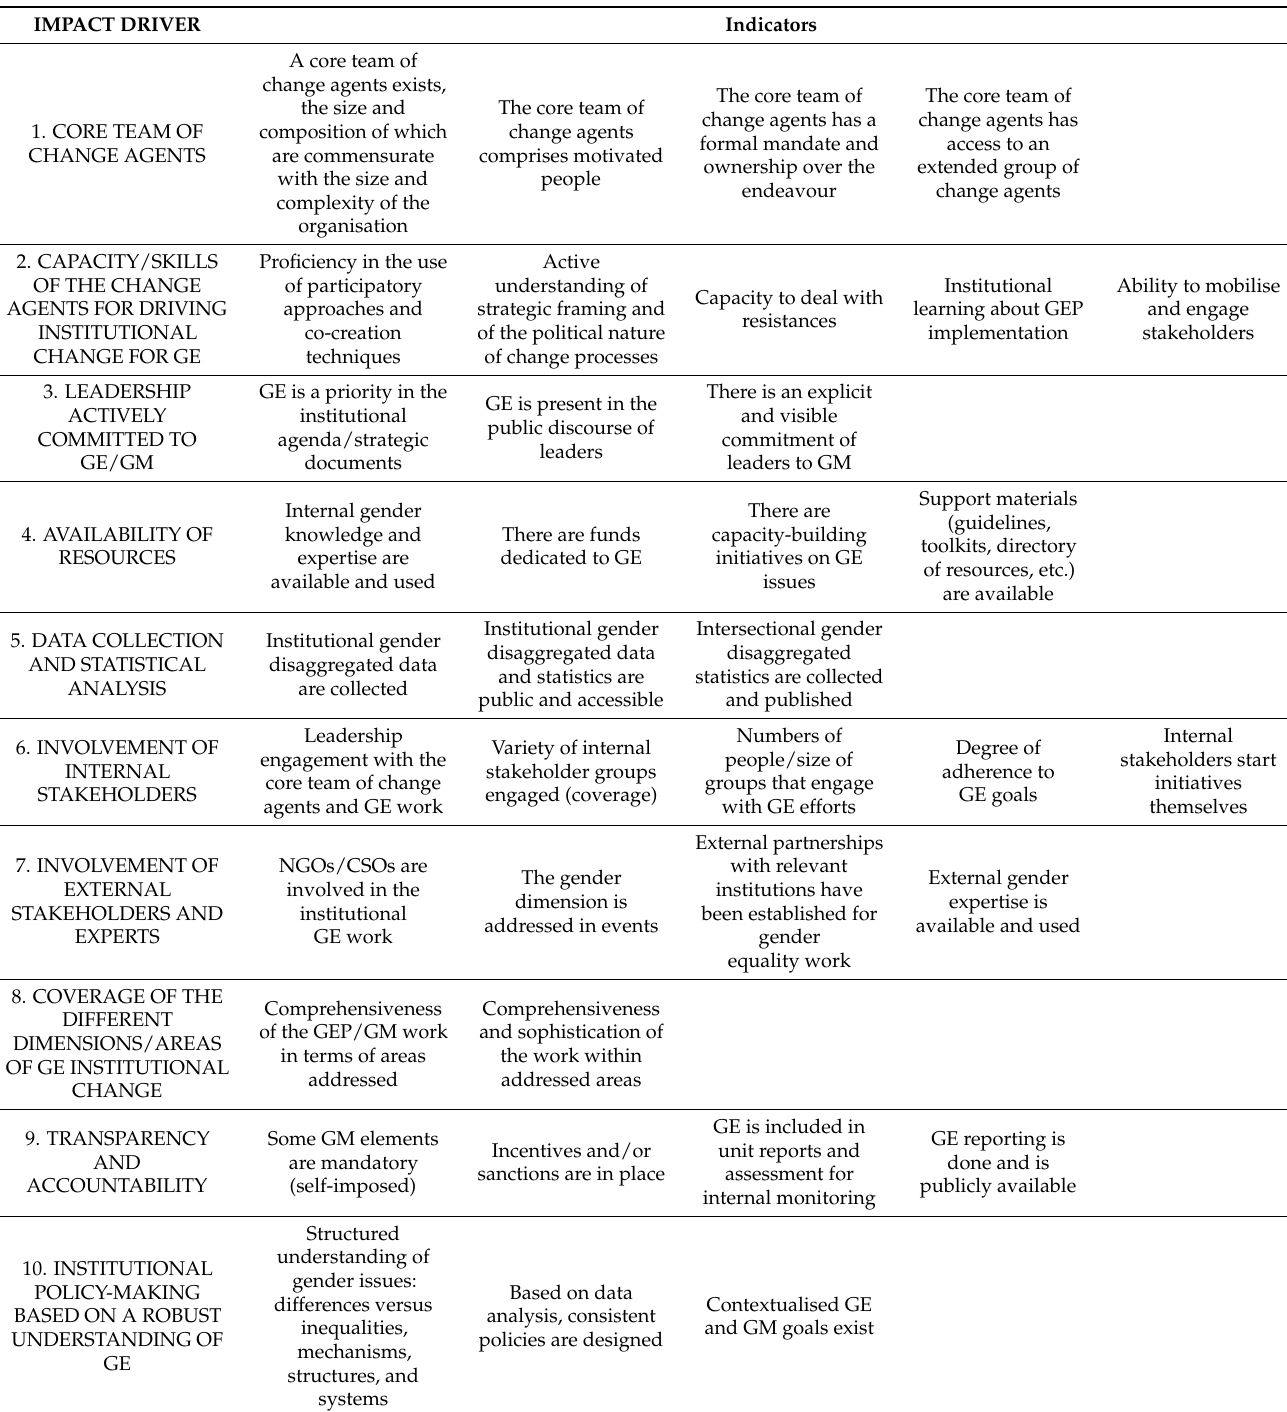
Table 3. Impact drivers and their indicators for gender mainstreaming in research and higher education